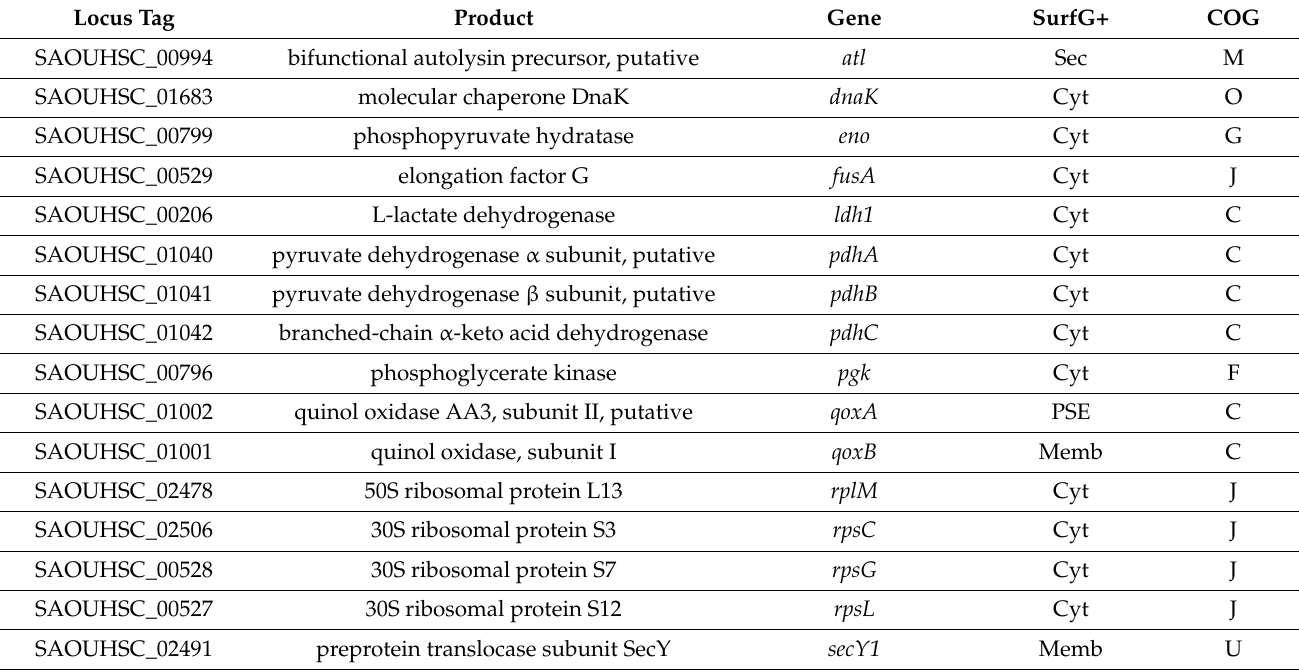
Table 2. S. aureus HG003 elements that were found in EVs in both RNA and protein form in all the conditions that were